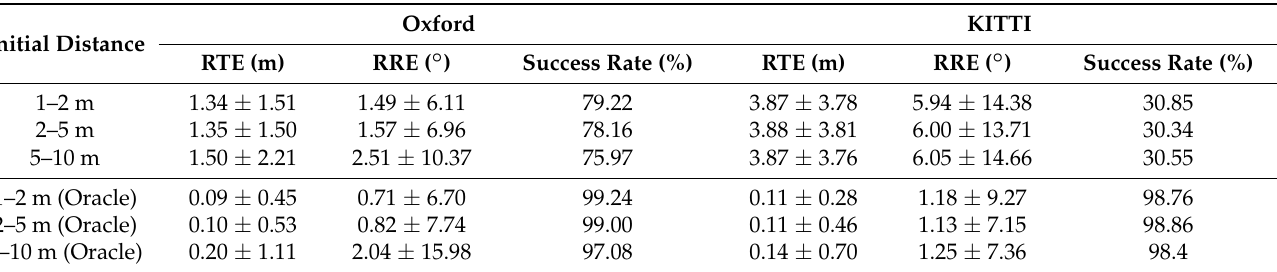
Table 6. Ablation studies. Three levels (i.e., 1–2 m, 2–5 m, 5–10 m ) of initialization were adopted to test the robustness of our “BC + RL” agent. The average value and standard deviation of RTE and RRE are reported. The notation “Oracle” refers to the frustum classification being substituted by the ground-truth label in the first classification stage. The success rate refers to the percentage of predicted poses falling within the threshold of ( 2 m,5 ◦ )